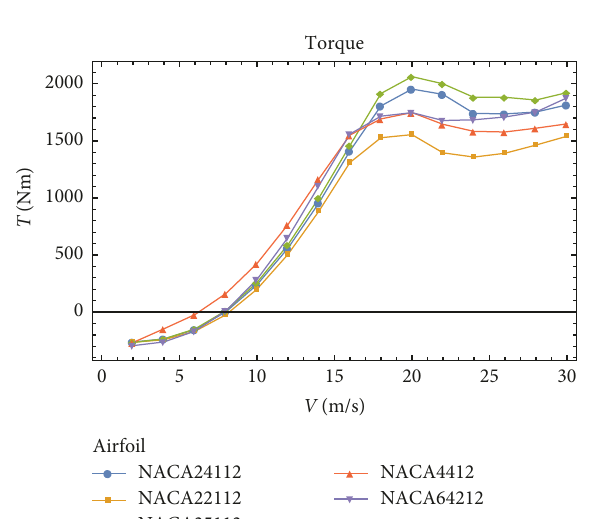
Figure 8: Curves C Tr vs. ( λ ) and C Tr vs. V.